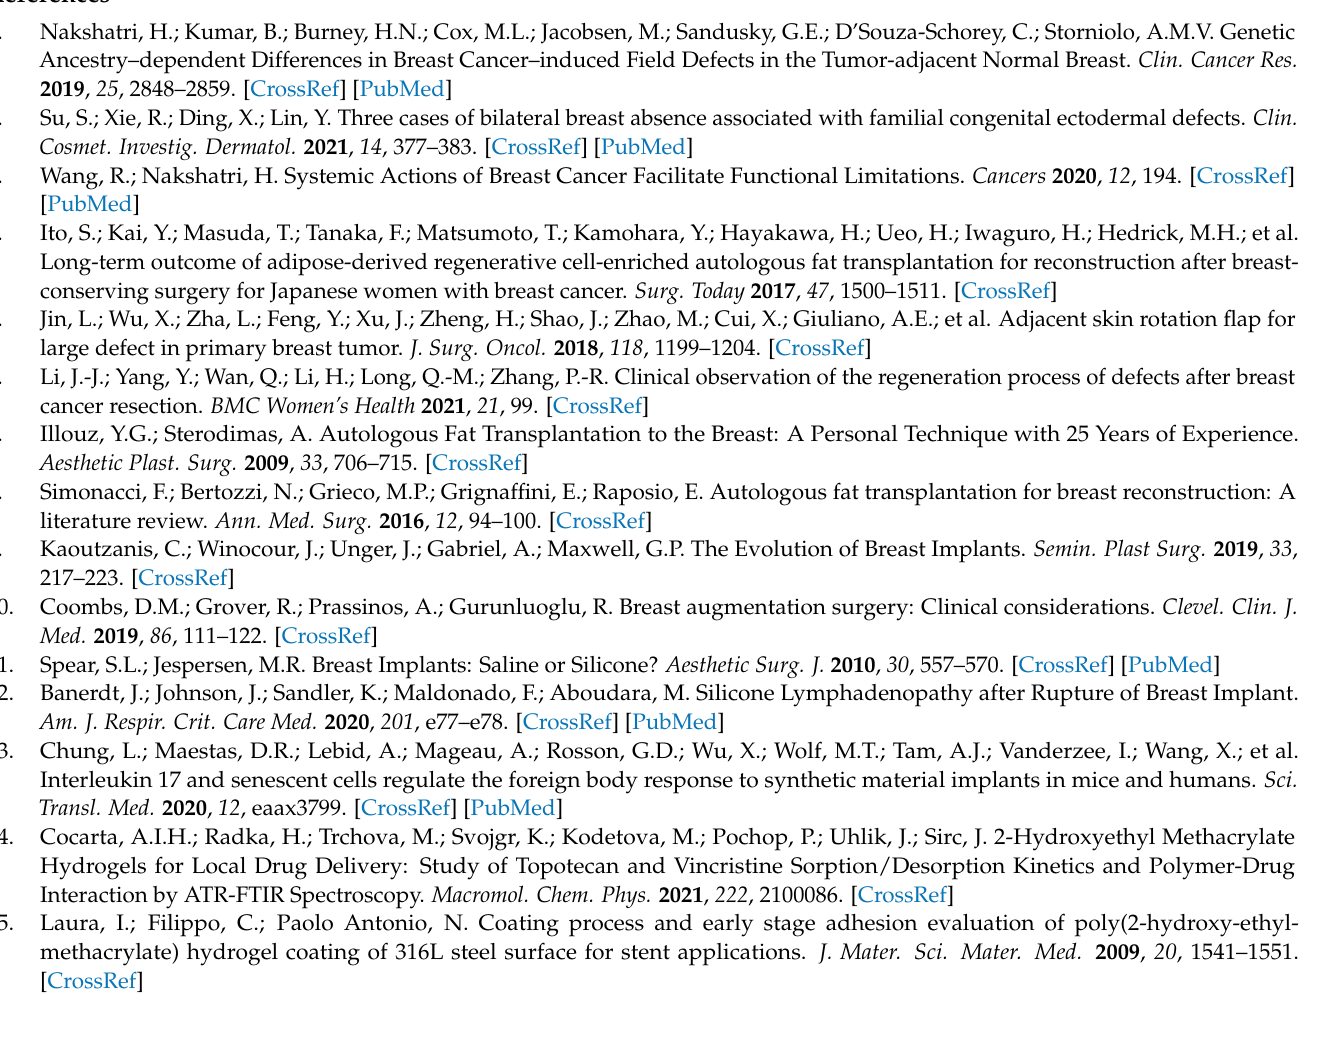
reference temperature is 10 ◦ C. Figure S5: The main curves obtained by shifting the frequency sweep curves of the PHM4 hydrogel at different temperatures, where the